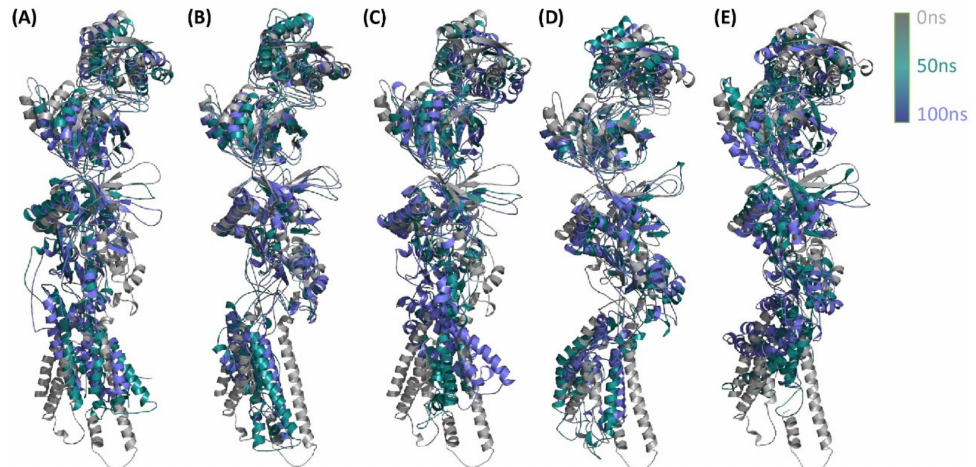
Figure 9. The RMSDs of GluN2B WT and GluN2B MTs at different simulation periods. The GluN2B WT behaves very differently from the GluN2B MTs . The mutant models (GluN2B p.Asn615Ile , GluN2B p.Thr685Pro , GluN2B p.Arg682Cys , and GluN2B p.Ser526Pro ) are shown in ( A ), ( B ), ( C ), ( D ) and ( E ) respectively.